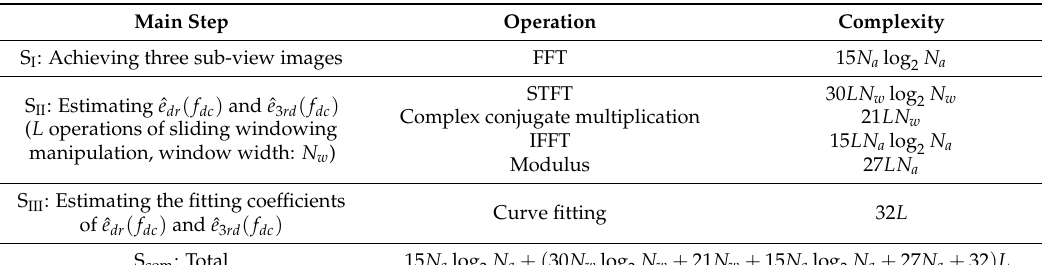
Table 1. The complexity of the main steps of the EMAM method.